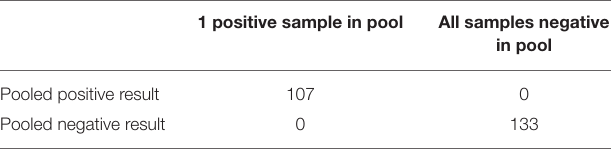
TABLE 1 | Comparison of pooled with individual sample results. 1 positive sample in